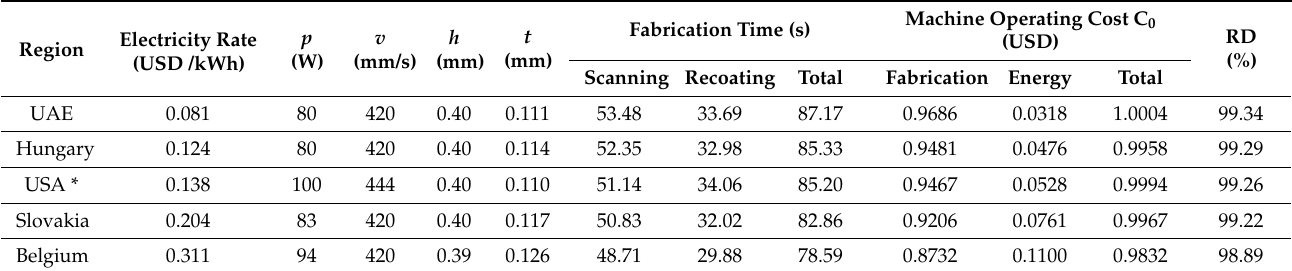
Table 9. Results of variation in the electricity rate with Model